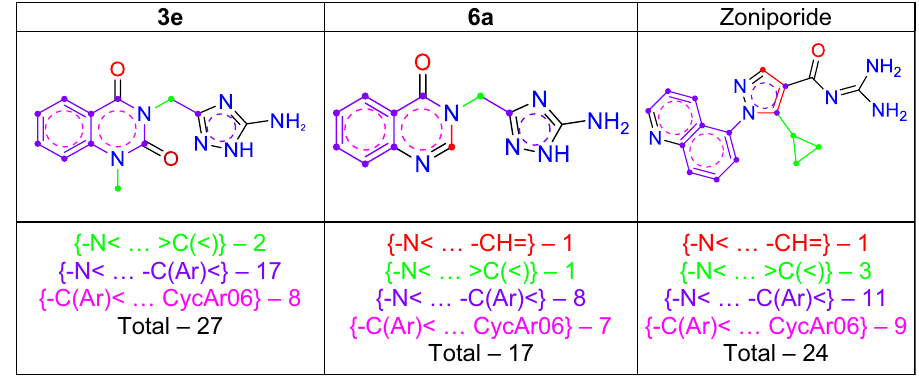
Table 4. The entry of the identified pharmacophore into the structures of the new most active NHE-1 inhibitors and